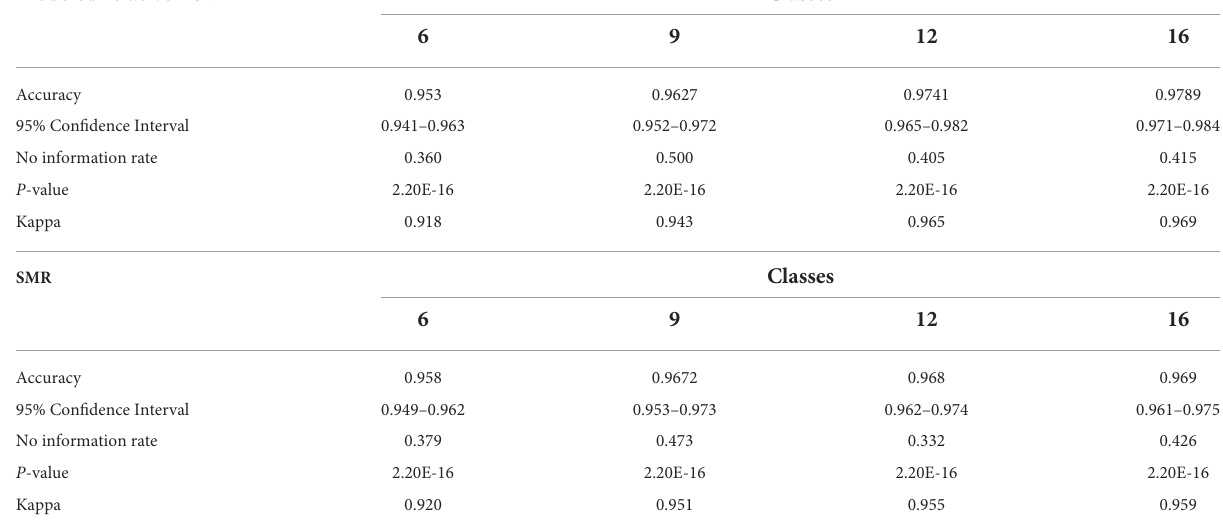
TABLE 10 Sensitivity analysis of the final DBN Model (DBN model